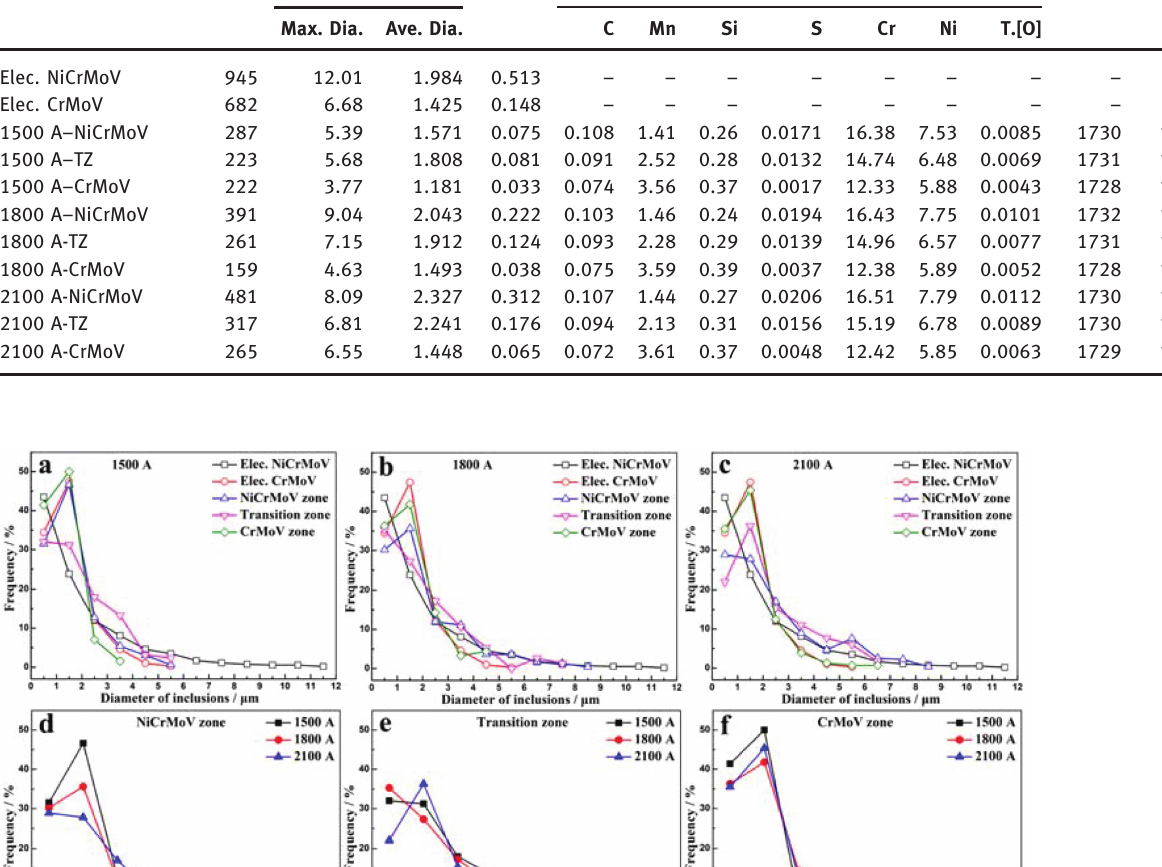
Table 2: Statistical results of inclusions and the chemical composition of electrode and dual alloy ingots: N - Number of observed inclusions, S a - ratio of total area of inclusions to total area of observed view fields. SampleNo.